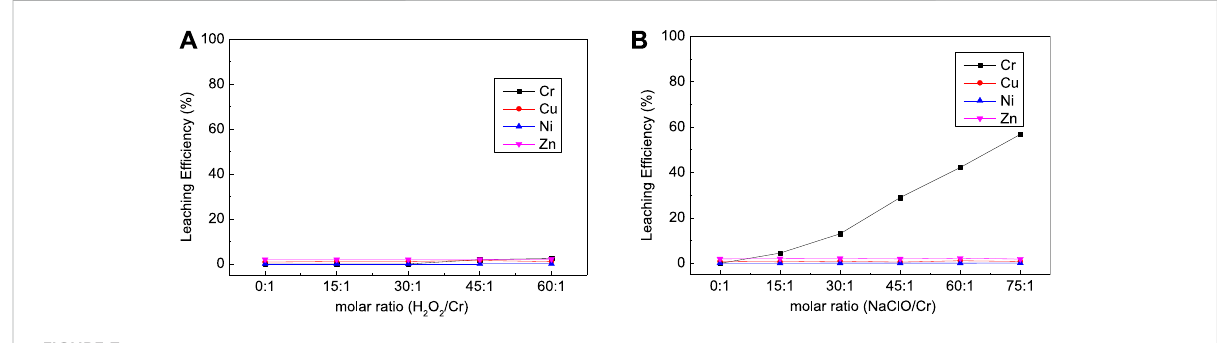
FIGURE 7 Effect of oxidizer dosage on the leaching results [ (A) with H 2 O 2 ; (B) with NaClO] for complex sludge (EPS2).